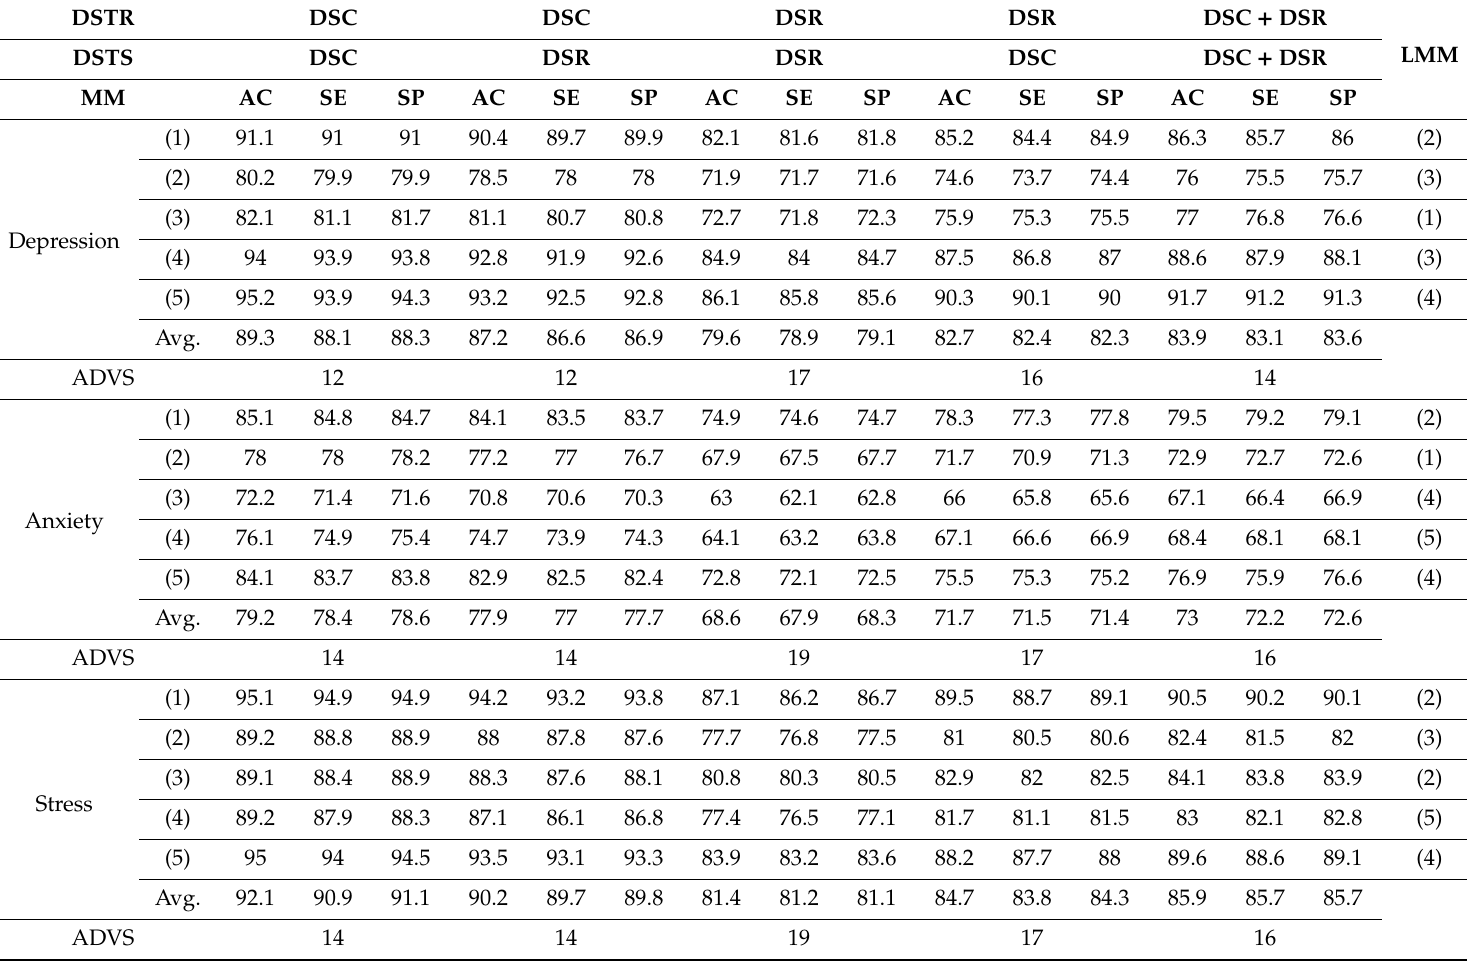
Table 1. DASS levels prediction accuracy, sensitivity, specificity, and average duration of analyzed video sample in intrasubject